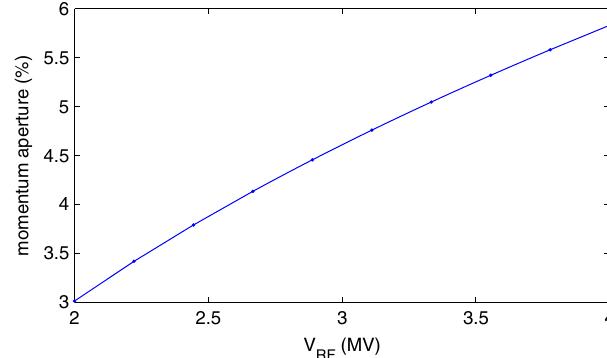
FIG. 5. Leading order estimate of momentum aperture vs rf voltage for Diamond.